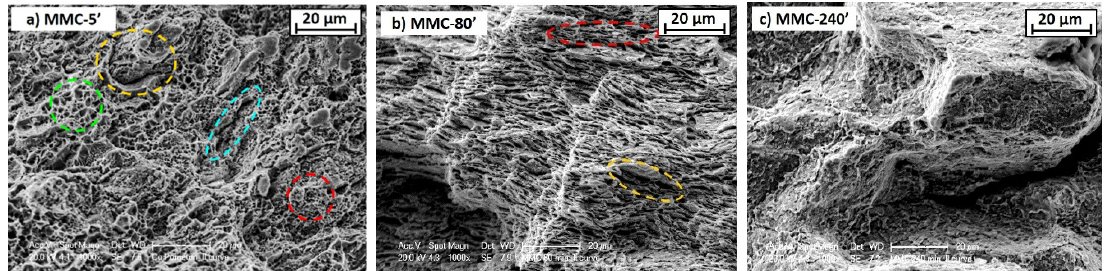
(cid:48) and ( c ) MMC-240 (cid:48)